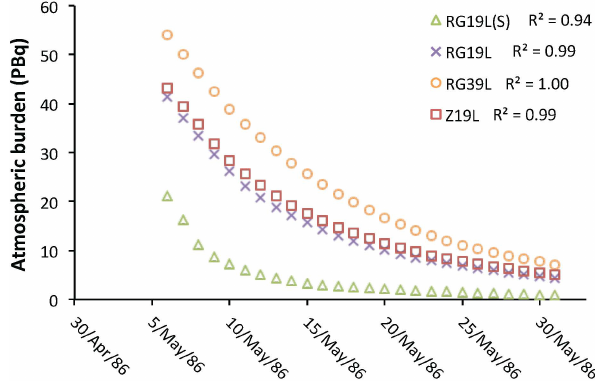
Fig. 6. Exponential decrease of the atmospheric burden of 137 Cs (in PBq) for the 4 different simulations of the Chernobyl accident (RG19L(S), RG19L, RG39L and Z19L). This graph was used in or- der to estimate the ecological half-lives of 137 Cs in the atmosphere. R 2 is the correlation coefficient of the exponential fitting that the burden of 137 Cs in the atmosphere